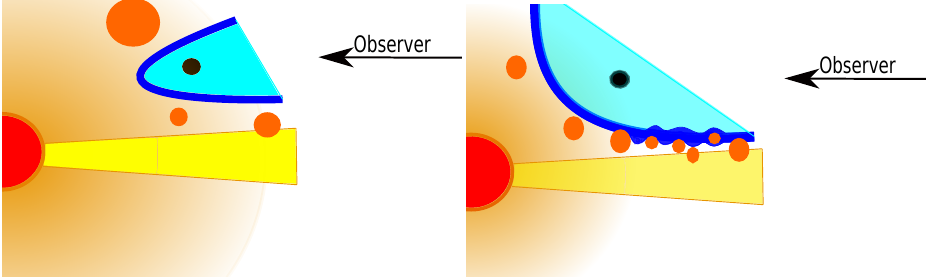
Figure 4. Schematic sketch of the 2017 ( left ) and 2021 ( right ) periastron passages. The positions of the star and the pulsar are shown with red and black circles, respectively. The equatorial stellar disk is depicted by the yellow shaded regions. The orange shaded regions and the orange circles depict the polar outflow and the clumps in the Be star’s disk, respectively. The cyan regions correspond to the unshocked electrons of the pulsar wind. The blue region corresponds to the border of the emission cone along which strongly/weakly shocked electrons of the pulsar wind are leaving the system (see text for more details). All lengths in the figure are not to